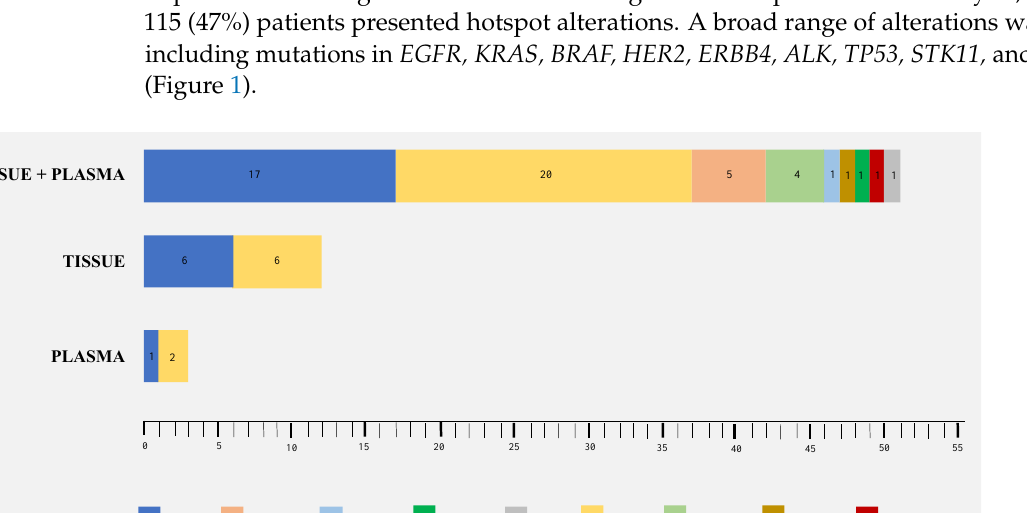
Table 3. Analysis of concordance between plasma and tissue genotyping on a patient basis (a), and hotspot alterations basis (b). Cases Compared (N) Concordant Cases [tDNA vs. ctDNA (N)]